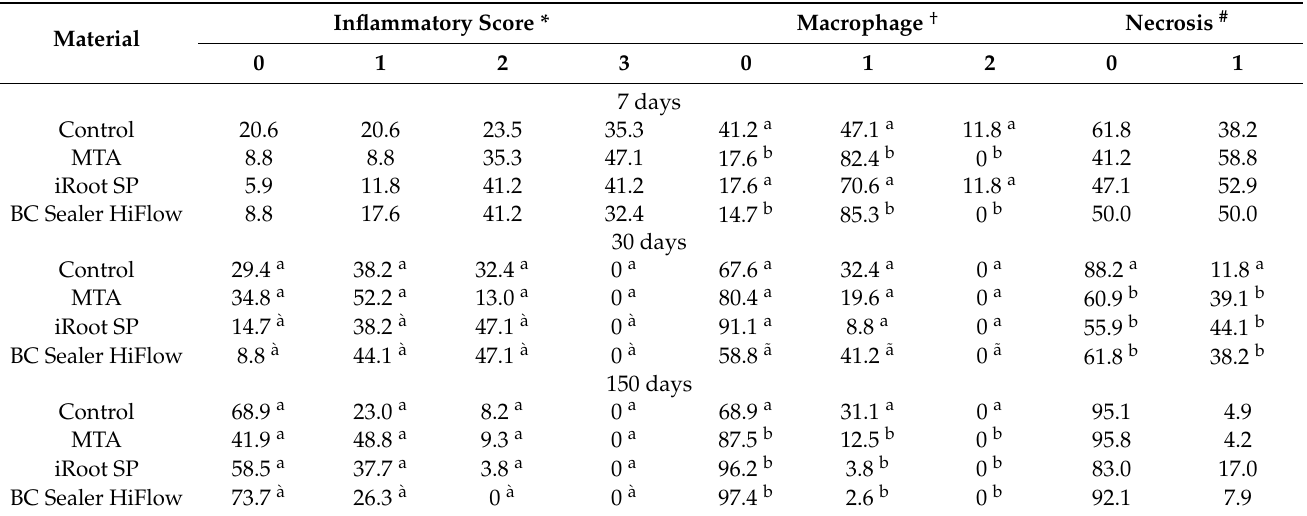
Table 3. Percentage of samples in each group categorized according to the inflammatory score, macrophage score and necrosis at each time